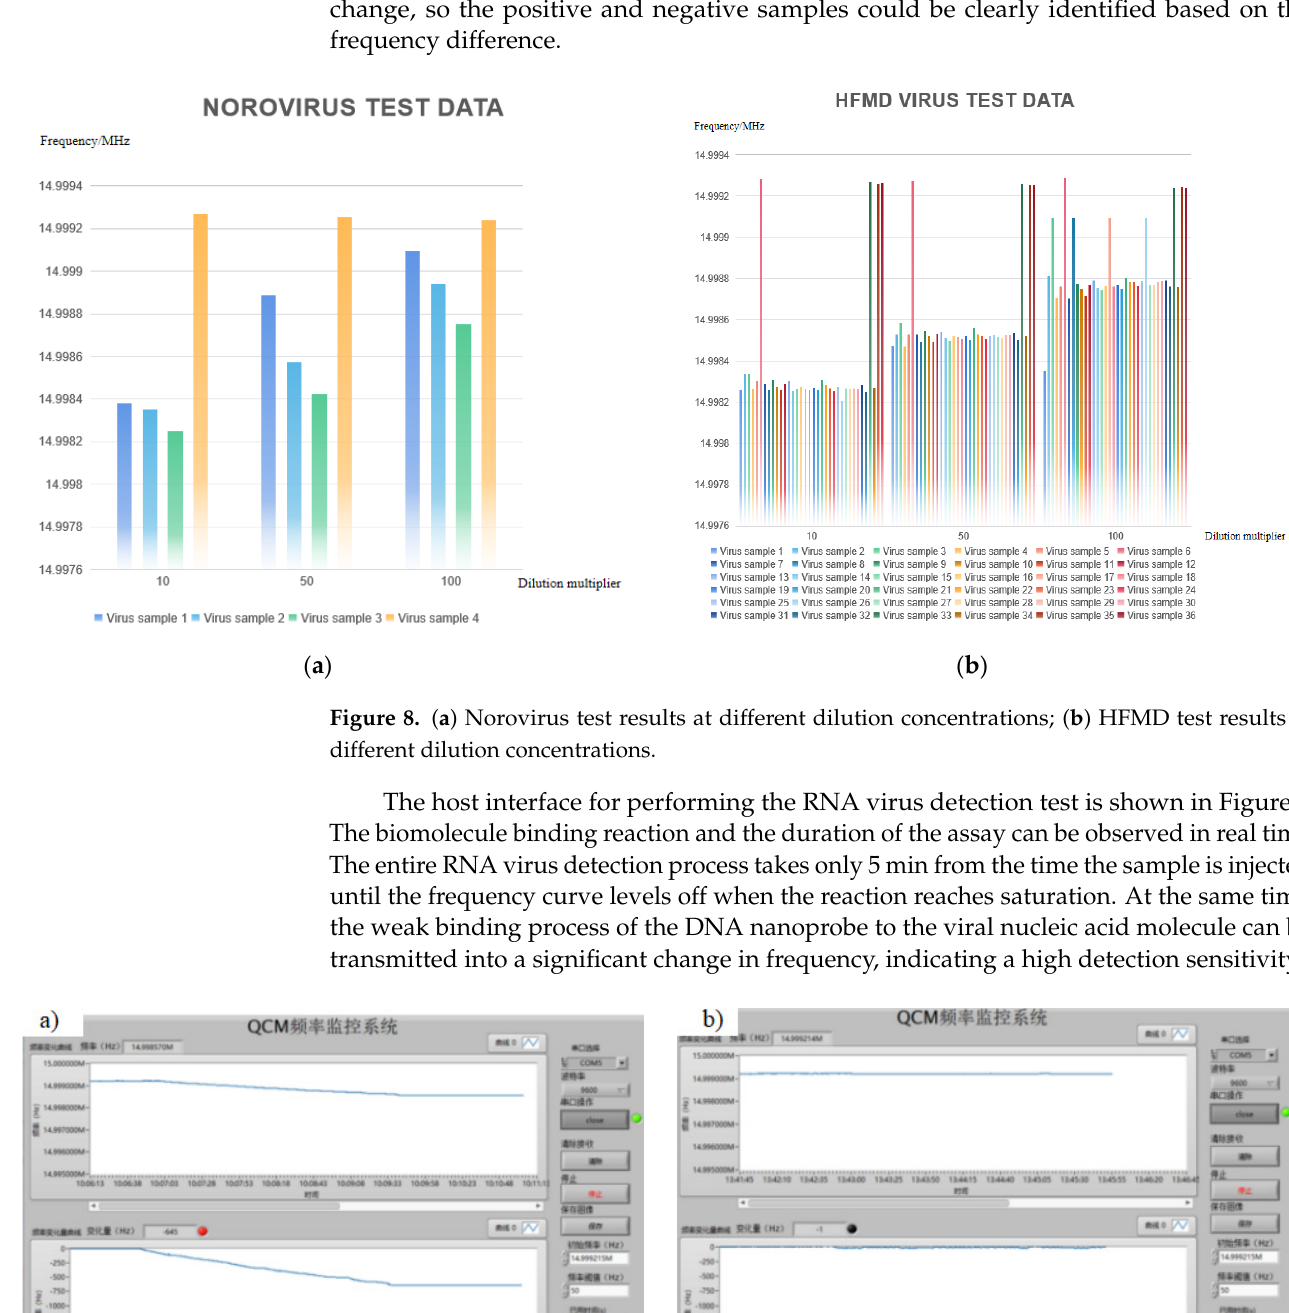
Figure 8. ( a ) Norovirus test results at different dilution concentrations; ( b ) HFMD test results at different dilution concentrations.